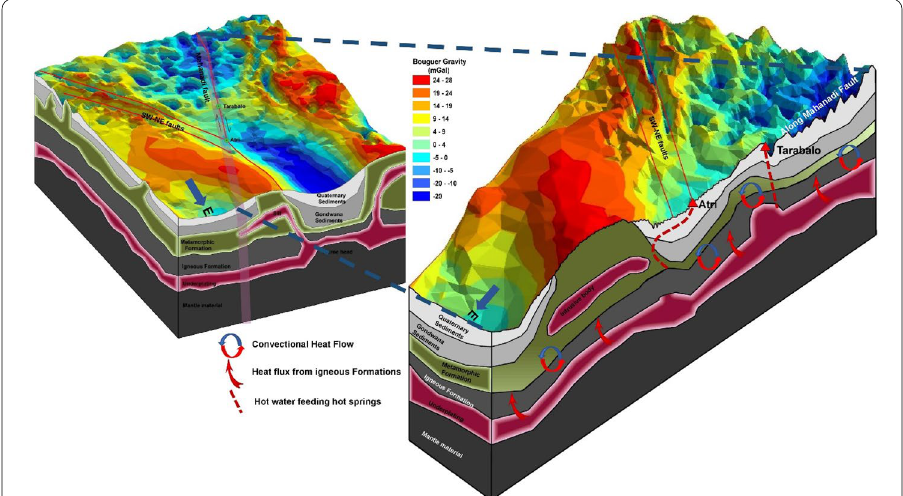
Fig. 12 3D conceptual model illustrating subsurface structure beneath Mahanadi rift basin and hydrothermal circulation along Mahanadi fault, overlaid by Bouguer gravity map of the